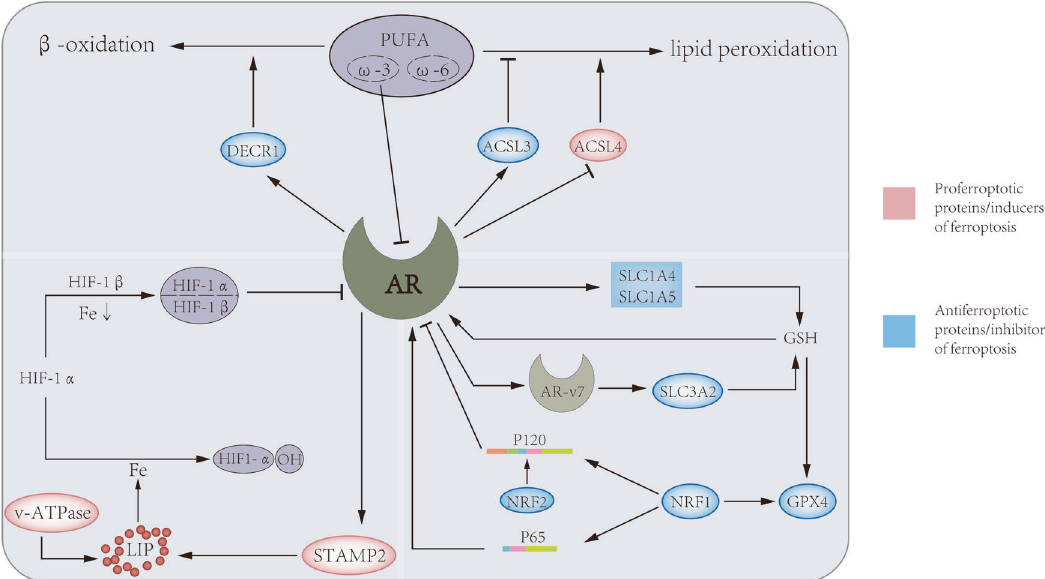
Fig. 2 The relationship between AR and ferroptosis. AR can regulate three metabolic pathways in ferroptosis. On the one hand, AR regulate DECR1 to promote the β -oxidation of PUFA, and regulate the lipid composition in the cell membrane through ACSL3 and ACSL4. On the other hand, AR and its mutant AR-V7 increase oxidative resistance by upregulating the level of GPX4 through GSH metabolism mediated by SLC1A4, SLC1A5 and SLC3A2, respectively. Furthermore, AR can promote STAMP2-mediated redox reactions and increase ferrous iron levels in the cytoplasm. At the same time, iron, GSH, and PUFA can also affect the level of AR through different